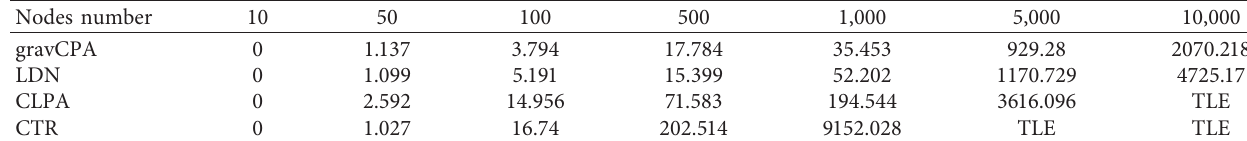
Table 6: Convergence time (ms) of four